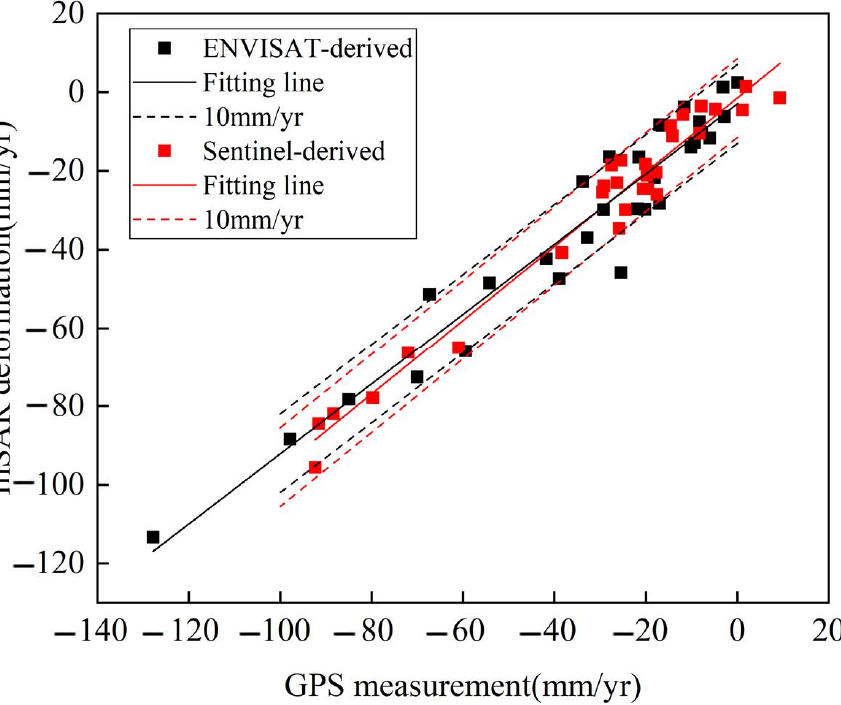
Figure 5. Correlation between GPS measurements and annual LOS deformation results of InSAR. Black scatter points are the ENVISAT-derived results, and black straight line is the line fitted by ENVISAT-derived results and GPS. Red scatter points are the sentinel-derived results, and red straight line is the line fitted by sentinel-derived results and GPS.